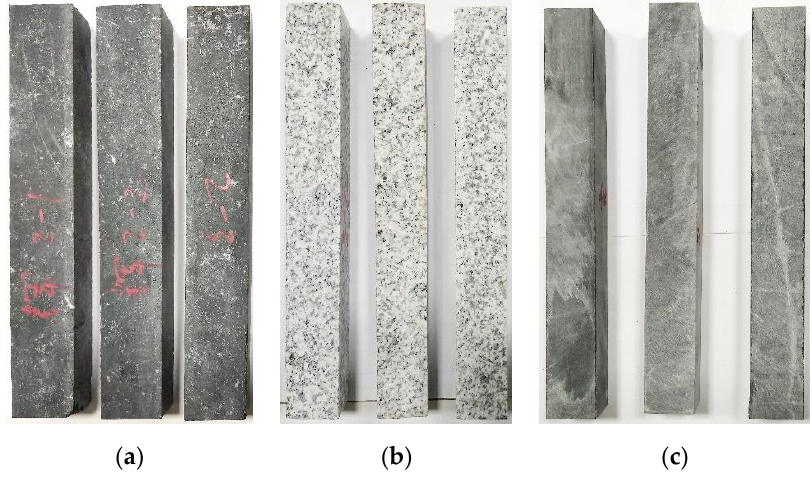
Figure 2. Three types of stone beam specimens: ( a ) diabase, ( b ) granite, and ( c ) limestone.